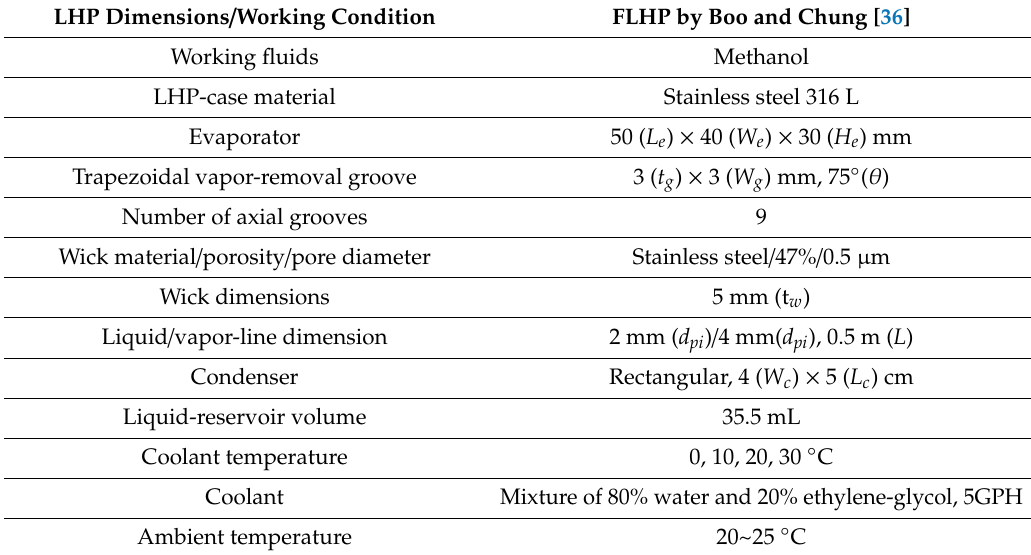
Figure 7. Liquid thin-film thickness for different pore diameters as function of axial location (see Figure 1).